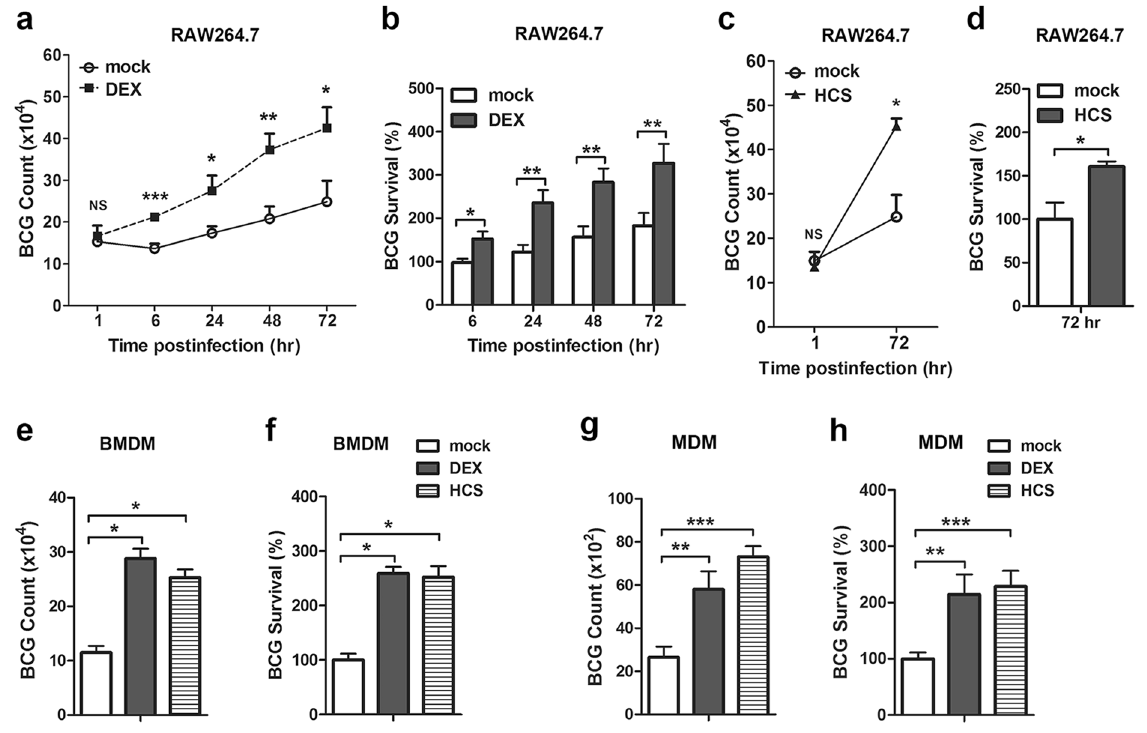
Figure 4. Increased mycobacterial survival in macrophages after glucocorticoids treatment. ( a – d ) RAW264.7 cells were pretreated with dexamethasone (DEX) (1 μ M), hydrocortisone (HCS) (1 μ M) or vehicle control ethanol for 24 hr and then challenged with M. bovis BCG (MOI 10) for 1 hr. The intracellular viable bacilli were determined by CFU assays at the indicated time post-infection ( a , c ). Survival rate was calculated compared with that of mock-treated cells ( b , d ). ( e–h ) BMDMs ( e , f ) and MDMs ( g , h ) were treated like RAW264.7 cells as described in ( a–d ). The intracellular viable bacilli were determined by CFU assays at 72 hpi ( e , g ). Survival rate was calculated compared with that of the mock-treated cells ( f , h ). Data are shown as the mean ± SEM of three independent experiments. * p < 0.05; ** p < 0.01; *** p < 0.001. NS, not